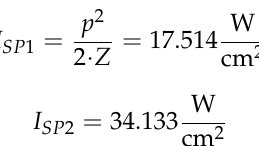
Figure 6. Focal distance calculation. At 3 MHz stimulation frequency the selected stimulation point is at a distance of 150 mm from the transducer (green circumference). This value results from the test made with the hydrophone and by a subsequent linear interpolation. Z R indicates the distance of Rayleigh (dotted line in red), in this case the Z R is located right after the cut-off region where the pression is very uneven. The orange line in the figure indicates the peak-to-peak pressure trend made by the USCND